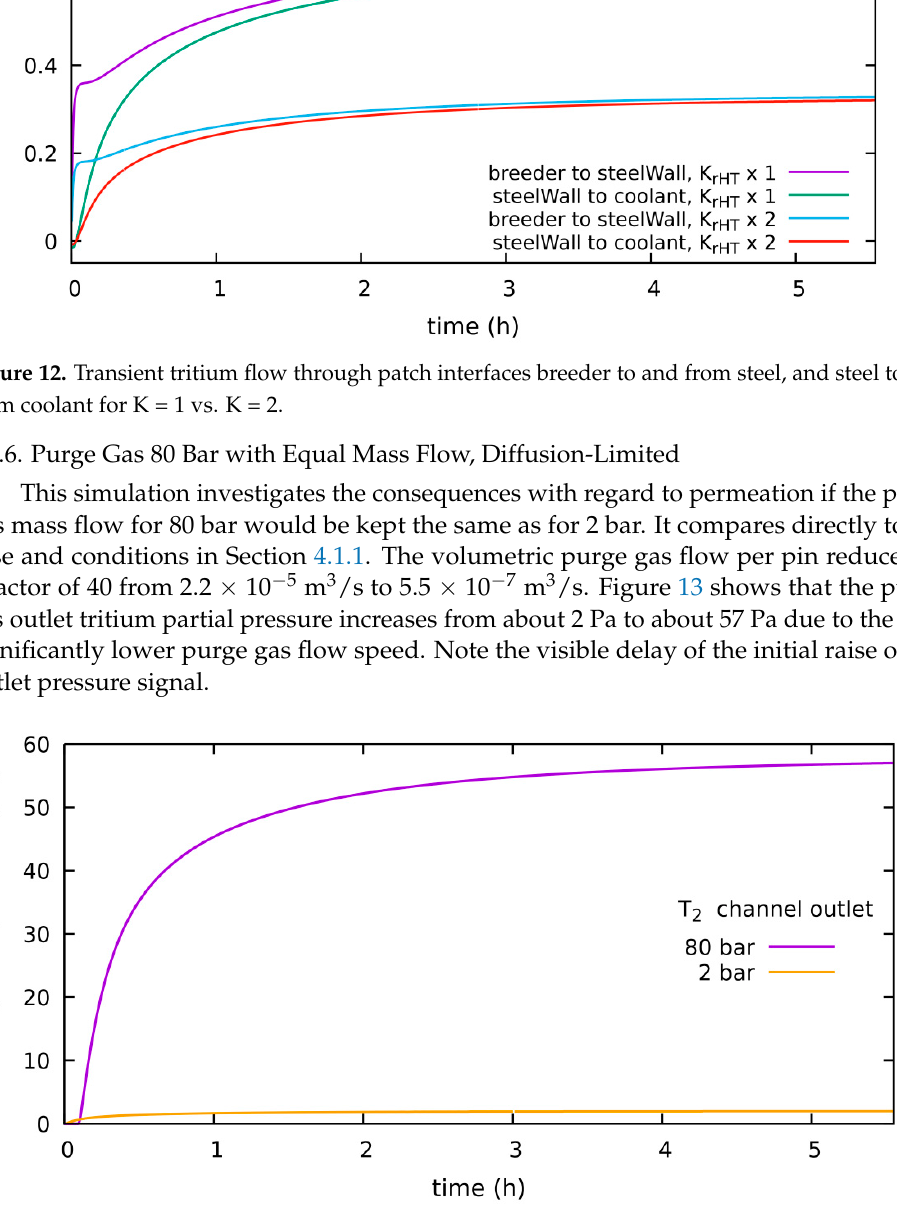
Figure 13. Transient T 2 partial pressure at purge gas channel outlet for 2-bar vs. 80-bar purge gas pressure at equal mass flow.